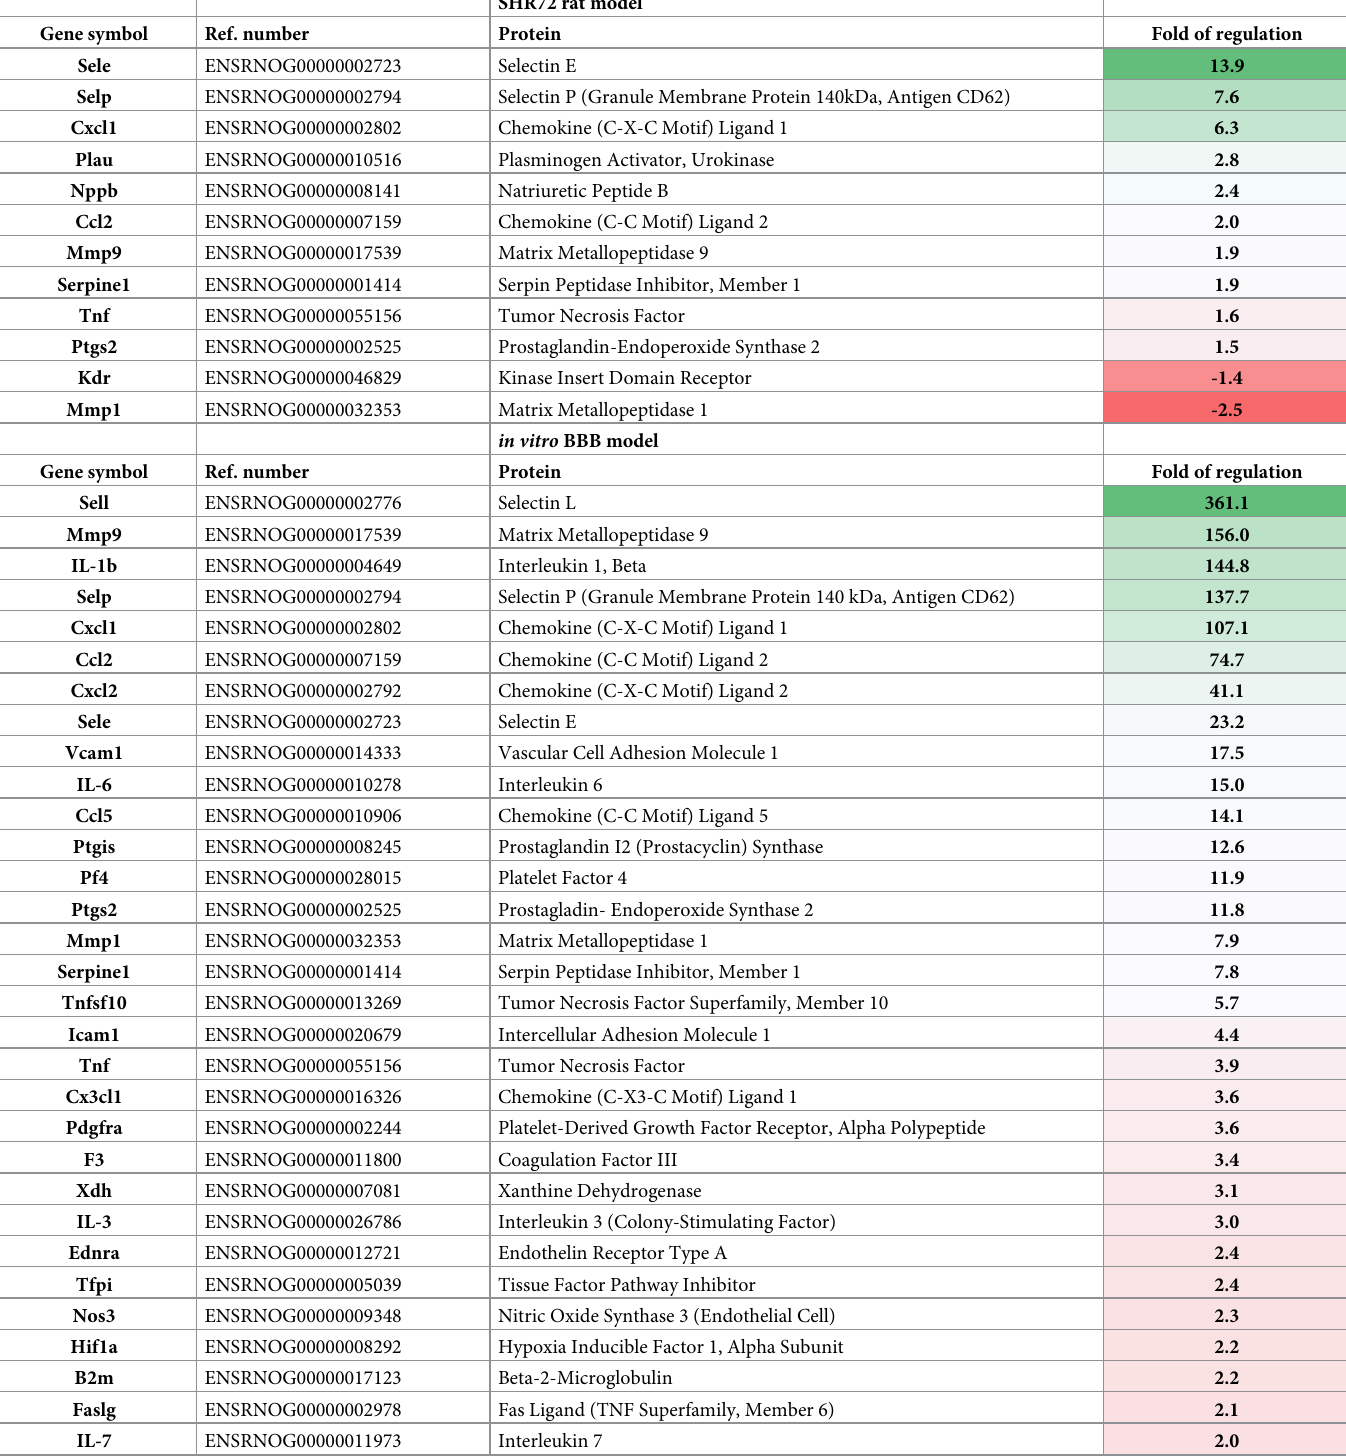
Table 1. Inflammatory mediators associated with gene signaling in endothelial cells and brain capillaries exposed to tau proteins. Transcriptomic analysis of endo- thelial cells from in vitro BBB model and isolated capillaries from brainstem of transgenic rats (SHR72) and control animals. RT-PCR reactions were run in triplicate with Actb and Rplp1 used as the reference genes. Minimum fold change was set at � 2, �